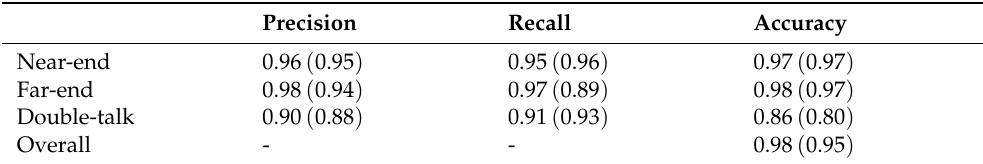
Table 3. Performance of the DTD. Numbers in parentheses represent the respective results of the multi-class classifier.